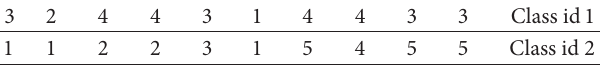
Table 1: Assumed class id for 𝐾 -means